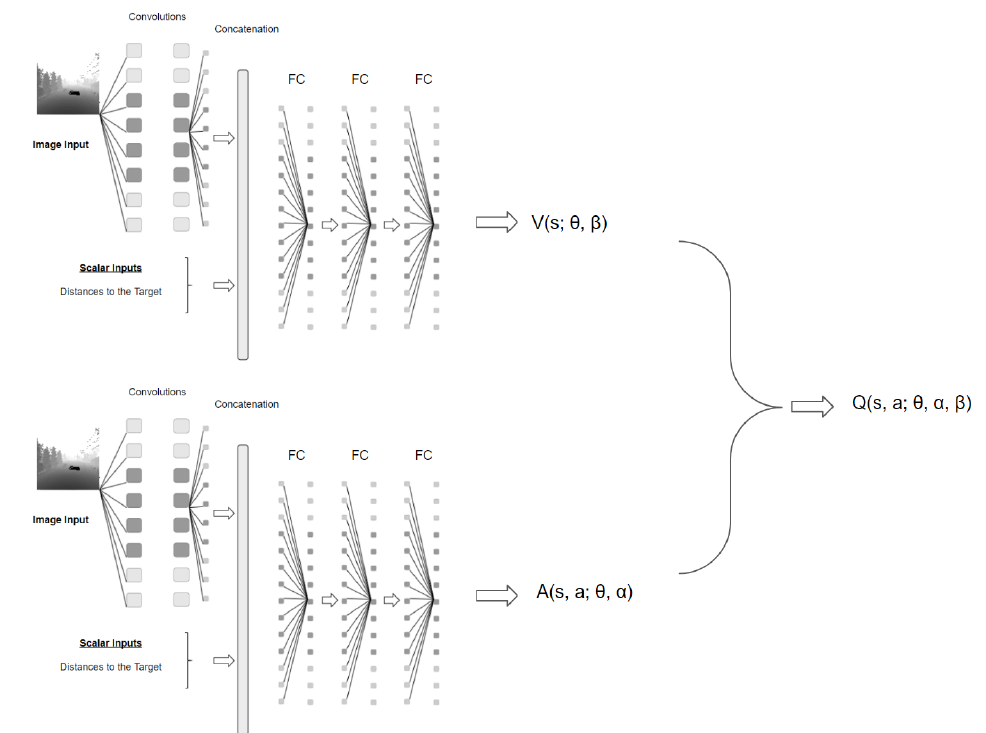
Figure 2. Agent Dueling